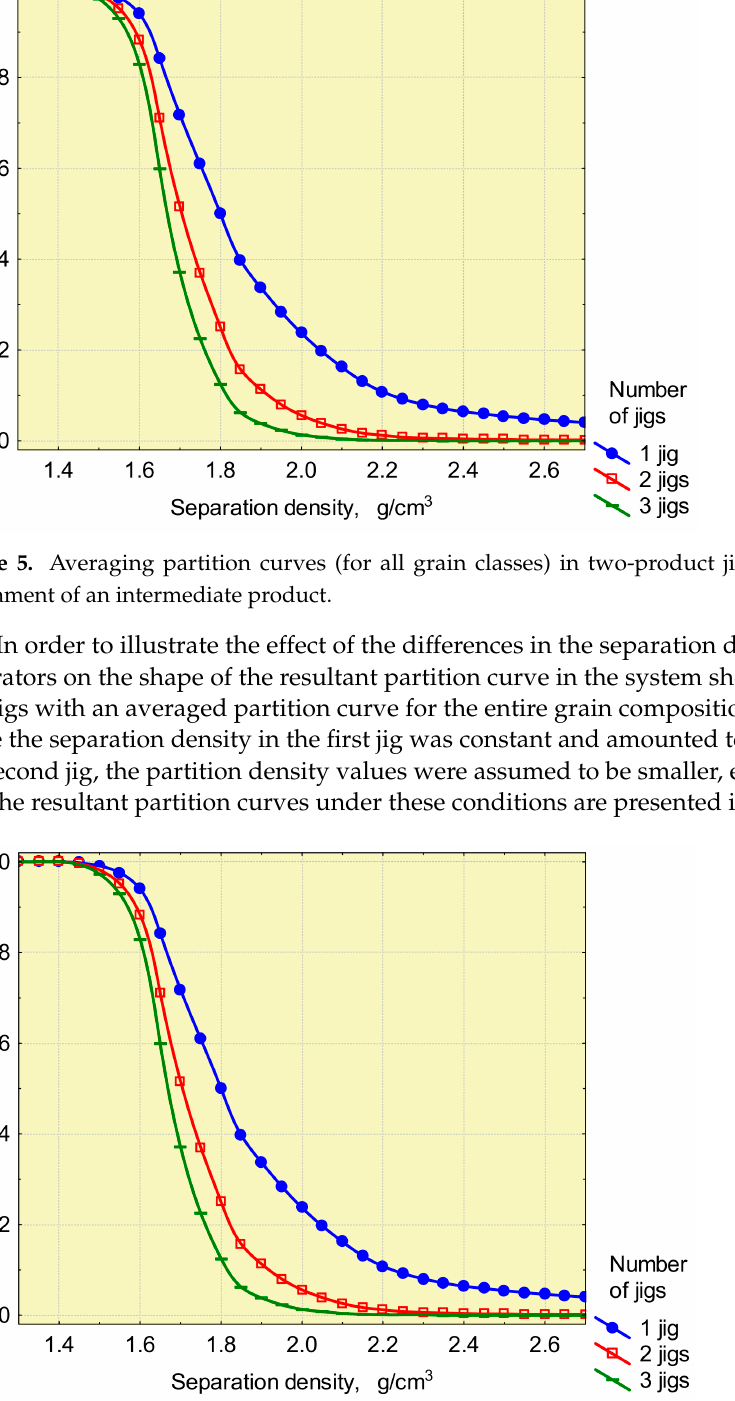
Figure 6. Averaging partition curves of two two-product jigs with secondary enrichment of interme- diate concentrate at different separation densities in a secondary